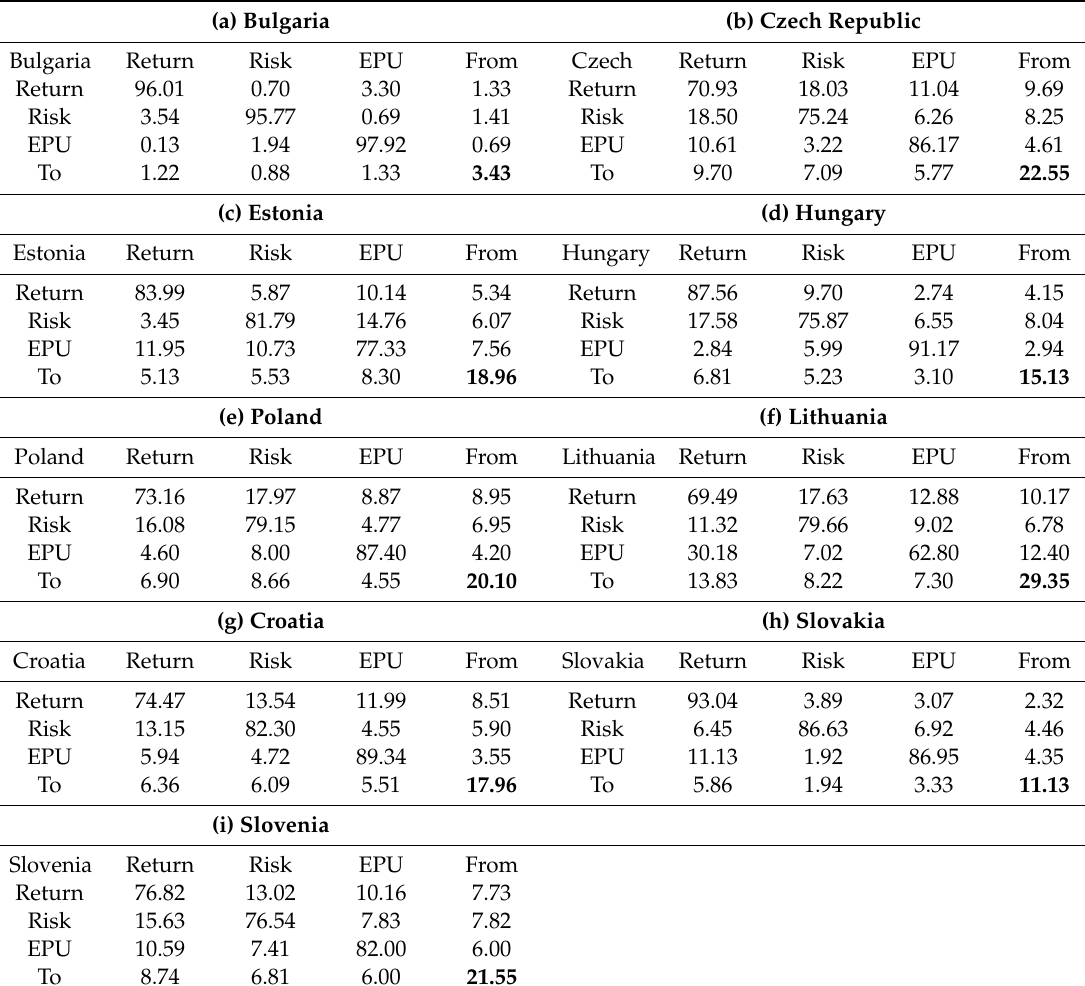
Table 3. Spillover tables for every country, full